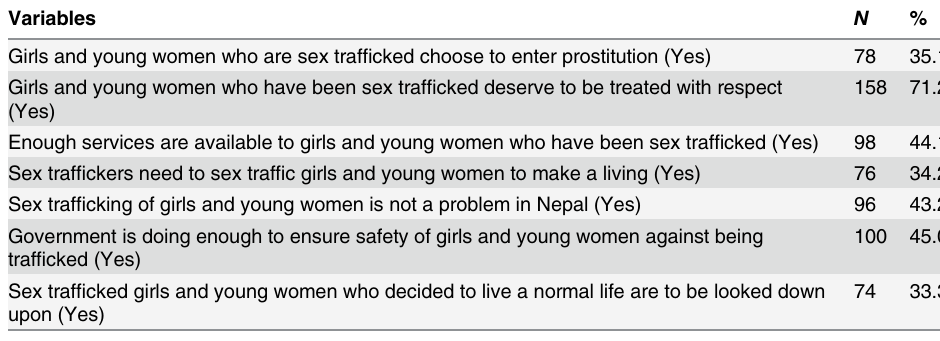
Table 3. Respondents ’ attitude about sexual trafficking (n = 222).